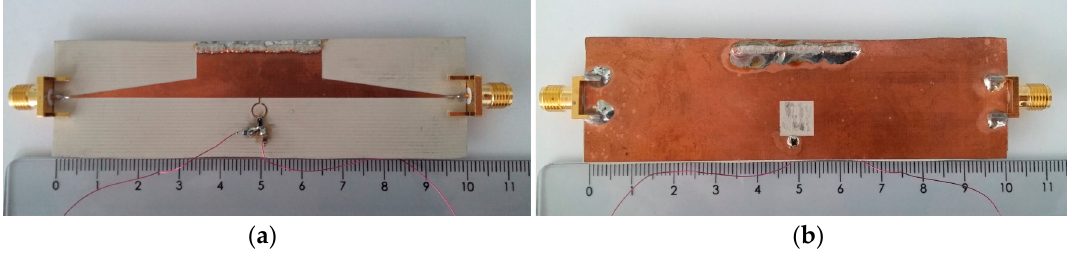
Figure 13. Photographs of the fabricated tunable HMSIW band-stop filter ( a ) top view and ( b ) bottom view.